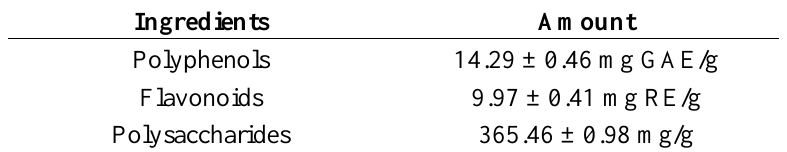
Table 1. Antioxidant composition of extract of P. alte-lobatum (EPA).